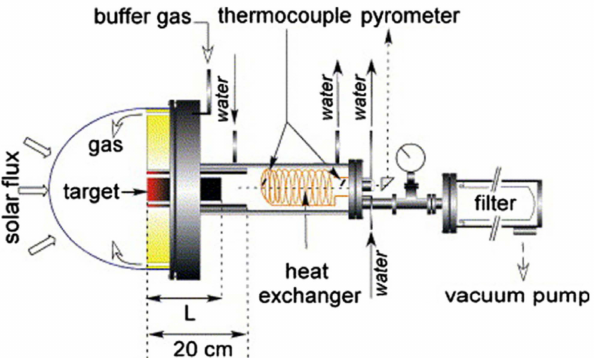
Figure 3. Typical scheme of the setup used in solar flux experiments. Reprinted with permission from Elsevier (Copyright 2004))